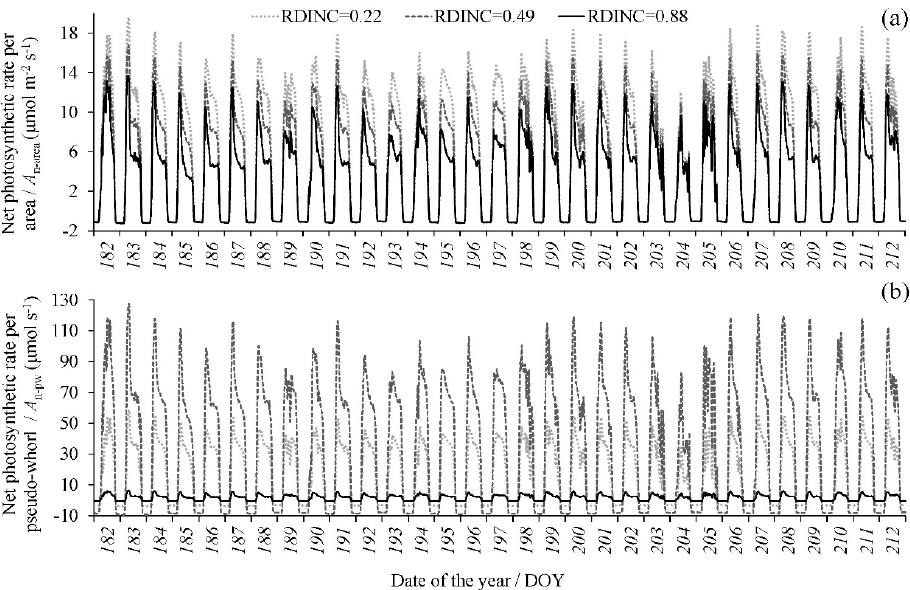
Figure 4. The dynamic simulation of ( a ) the net photosynthetic rate ( A n ) per area ( A n-area ) and ( b ) the total A n per pseudowhorl ( A n-pw ) (only tree I was used as an example during July). Three pseudowhorls with relative depths into the crown (RDINC) of 0.22, 0.49 and 0.88, representing the upper, middle and lower crowns, respectively, were selected.